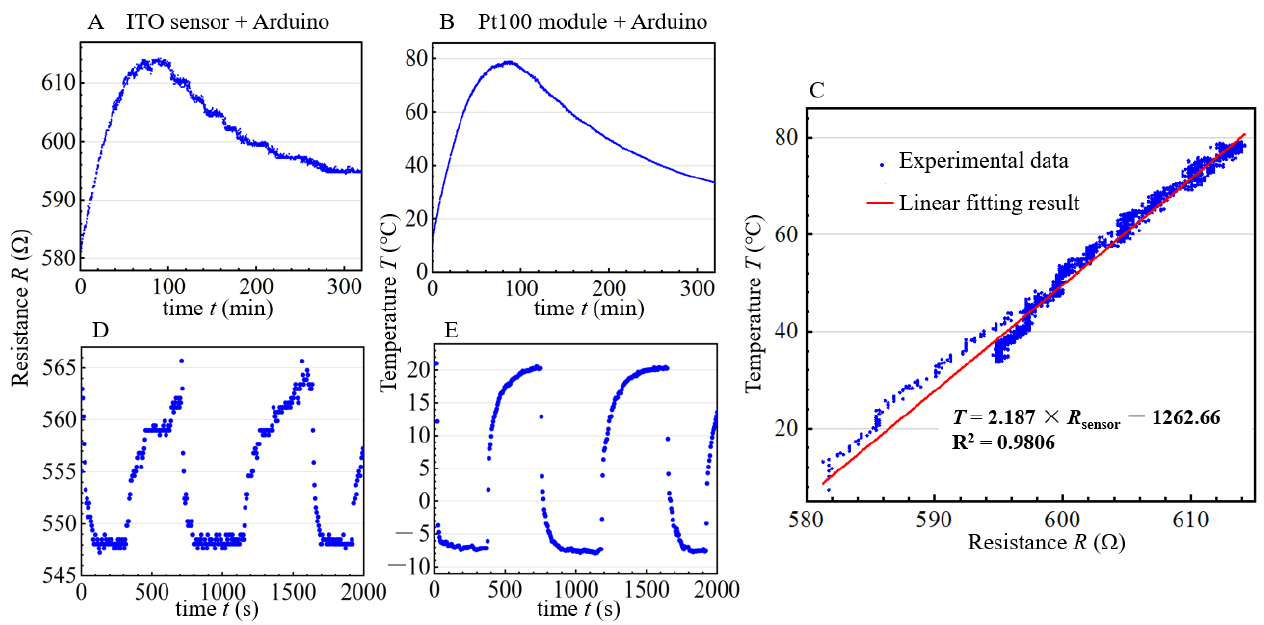
Figure 3. Calibration of ITO on–chip temperature sensor. ( A ) ITO resistance recorded during slow temperature-changing process above room temperature; ( B ) slow temperature-changing process above room temperature recorded by Pt100; ( C ) linear fitting result for ITO sensor calibration; ( D ) ITO resistance recorded during fast temperature–changing process below room temperature; ( E ) fast temperature-changing process below room temperature recorded by Pt100.